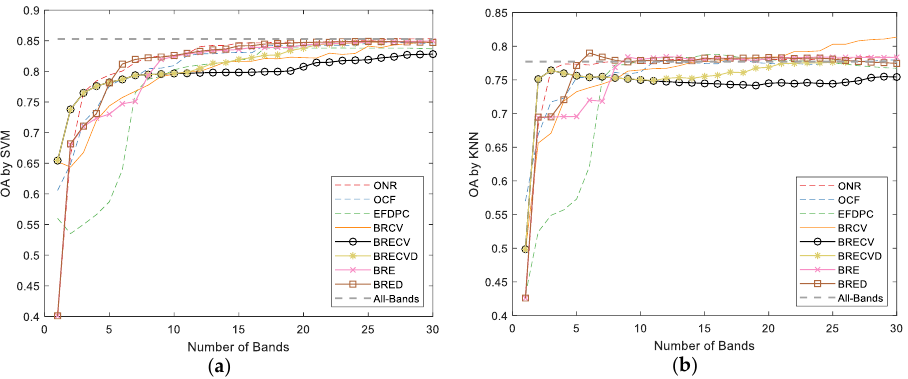
Figure 7. OA curves produced by SVM and KNN classifiers for the Taita Hills data set. ( a ) The OA curves produced by SVM classifier. ( b ) The OA curves produced by KNN classifier.